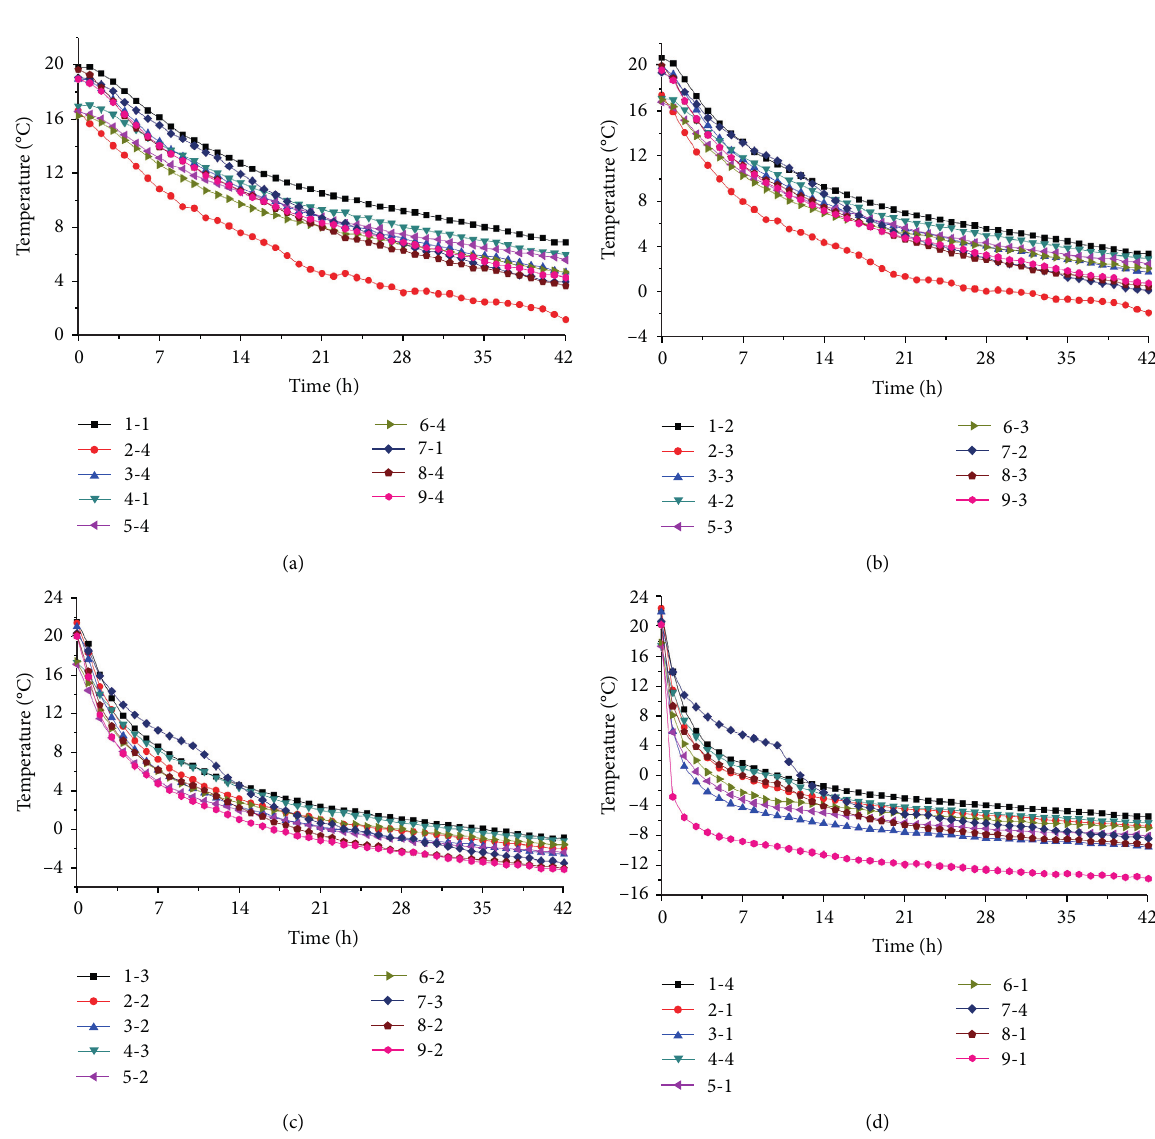
Figure 11: Temperature-time curves of the loop monitoring points: (a) 150mm; (b) 100mm; (c) 50mm; (d) 0mm.